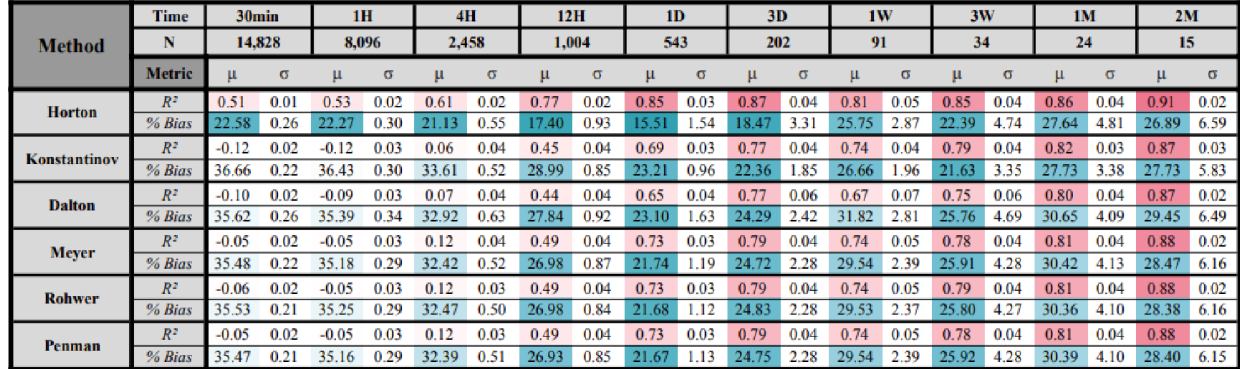
Table 1. Performance metrics ( R 2 and percent bias) for evaporation methods using observed data inputs. Darker shades of teal and pink